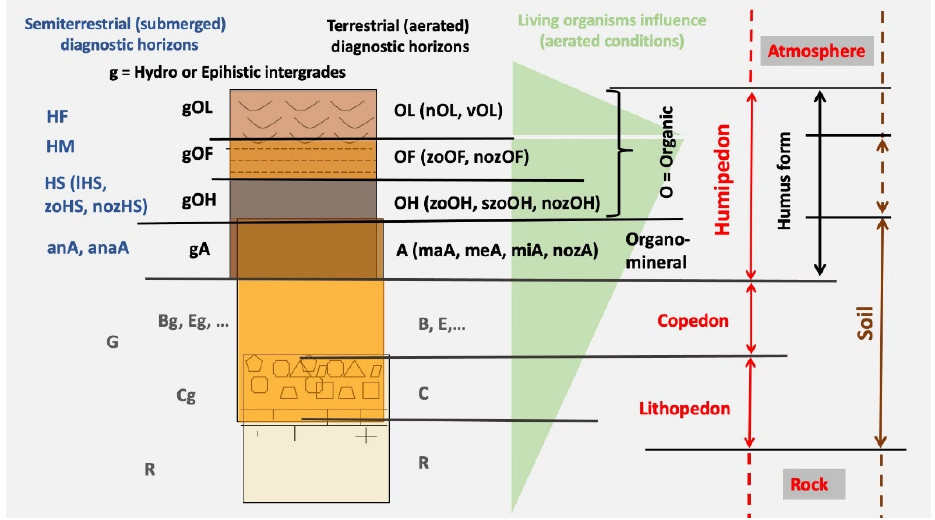
Figure 1. Soil subunits and horizons. From [43], modified (addition of Semiterrestrial diagnostic horizons). Humipedon horizons enlarged: Semiterrestrial Histic organic horizons [31] HF, HM, HS (lHS, zoHS, nozHS) and organomineral anA (Anmoor A horizon); Hydro and Epihistic intergrades horizons [52,53] gOL, gOF, gOH, gA; Terrestrial horizons “O” organic (OL, OF, OH; zo = zoogenic; noz = nonzoogenic; szo = slightly zoogenic) and “A” organomineral horizons (maA, meA, miA, nozA, respectively biomacro, biomeso, biomicrostructured, and nonzoogenic A horizons) [30]. Semiterrestrial humipedons may be very thick (peaty soils, until many m) or superficial (<1 m) and lying on hydromorphic Copedon and Lithopedon horizons; Terrestrial humipedons occupy approximately the first 30 cm of the profile, followed by the more mineral “E” and “B” Copedon horizons resting on “C” horizons and the weathered, altered “R” layer of the Lithopedon. Although organisms are present throughout the soil profile, they are more numerous in the Humipedon, for reasons related to the availability of nutrients and organic matter as a food resource. Reprinted/adapted with permission from Ref. [43]. 2019, Soil Sci. Soc. Am. J. ”. More details on “Copyright and Licens-